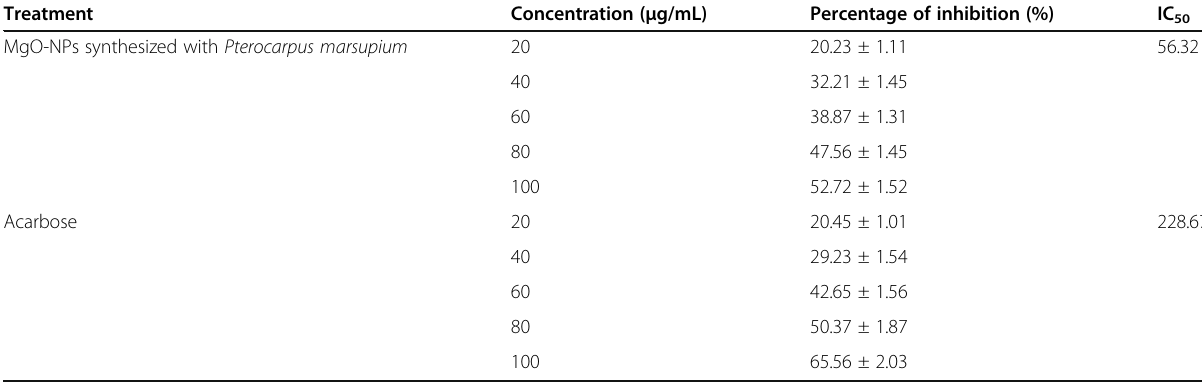
Table 3 Alpha-amylase inhibitory activity by Pterocarpus marsupium synthesized MgO-NPs